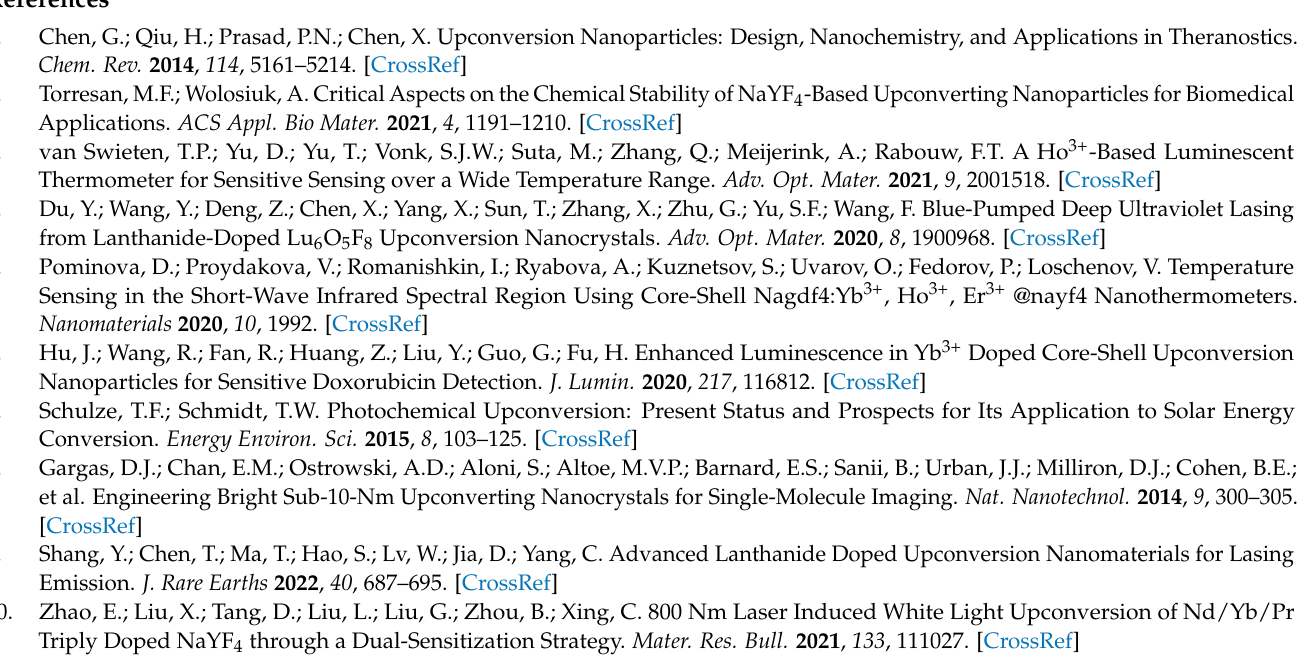
Table S1: Unit cell parameters of the NaY 0.8 Ln 0.2 F 4 samples; Table S2: Unit cell parameters of the NaY 0.6 Ln 0.4 F 4 samples; Table S3: Mean particle diameter of the NaY 0.8 Ln 0.2 F 4 samples; Table S4: Mean particle diameter of the NaY 0.6 Ln 0.4 F 4